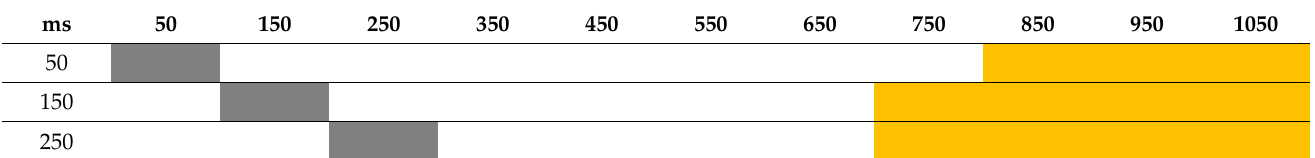
Figure A8. RMSE ( left ) and cross-correlation ( right ) of MNF algorithm for different window sizes. Table A8. Statistical significance between window sizes for MNF algorithm. Green indicates statistically significant difference ( p < 0.05; Bonferroni-corrected) for the RMSE metric, and orange indicates significant difference ( p < 0.05; Bonferroni-corrected) for the cross-correlation metric. Grey indicates diagonal fields.